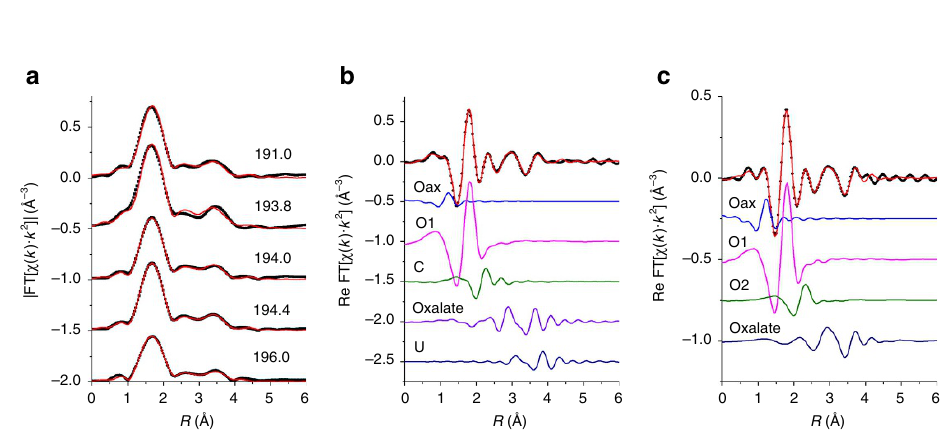
Figure 2 | U L III -edge EXAFS spectra and models. ( a ) Magnitude of Fourier transform spectra are offset for clarity for following depths (from top to bottom in m-bgs): 191.0, 193.8, 194.0, 194.4 and 196.0. ( b , c ) Real part of Fourier transform of the sediments from depths 191.0m ( b ) and 196m ( c ). The components of the model are shown offset beneath the total model (i.e., O ax , O1, C, Oxalate, U and O2). Contributions from O ax : axial oxygen atoms from uranyl (U VI ); O1, O2: oxygen atoms bound to U (VI) and U (IV) at a longer distance than U-O ax C: carbon atoms from bidentate carbon group; Oxalate: oxalate-like ligand group; U: U neighbours in uraninite are shown in B. EXAFS spectra (symbols) and models (lines).